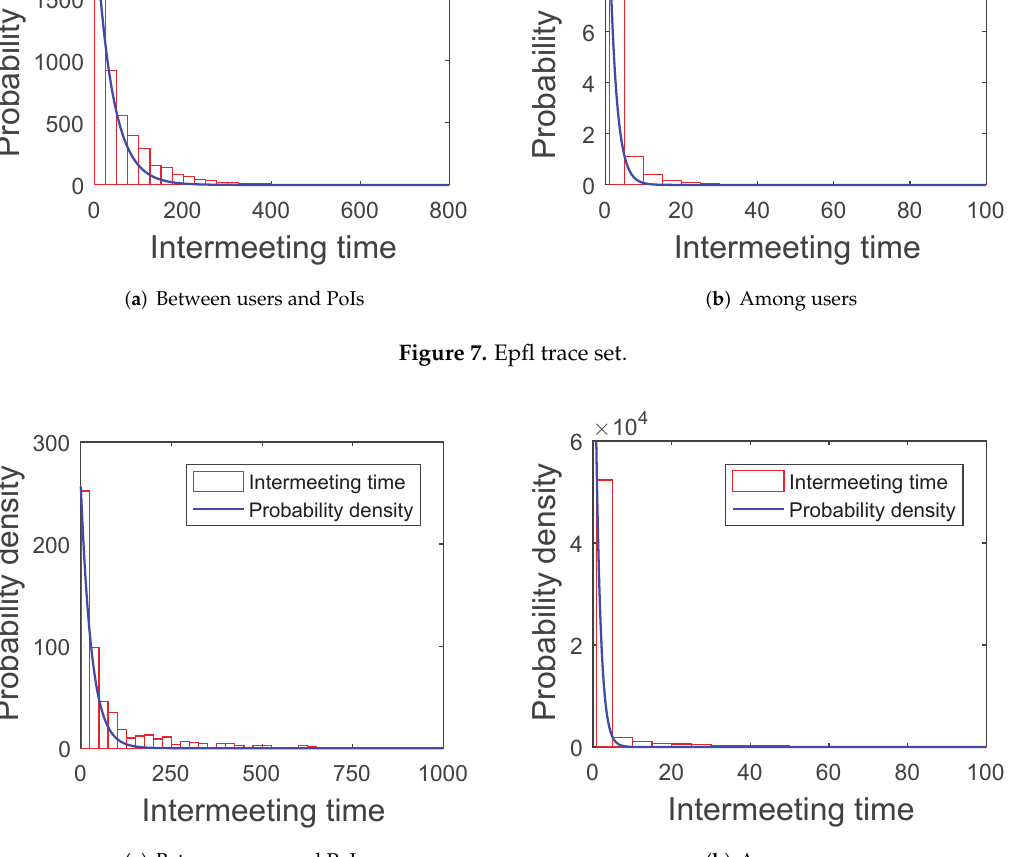
Figure 8. Geolife trace